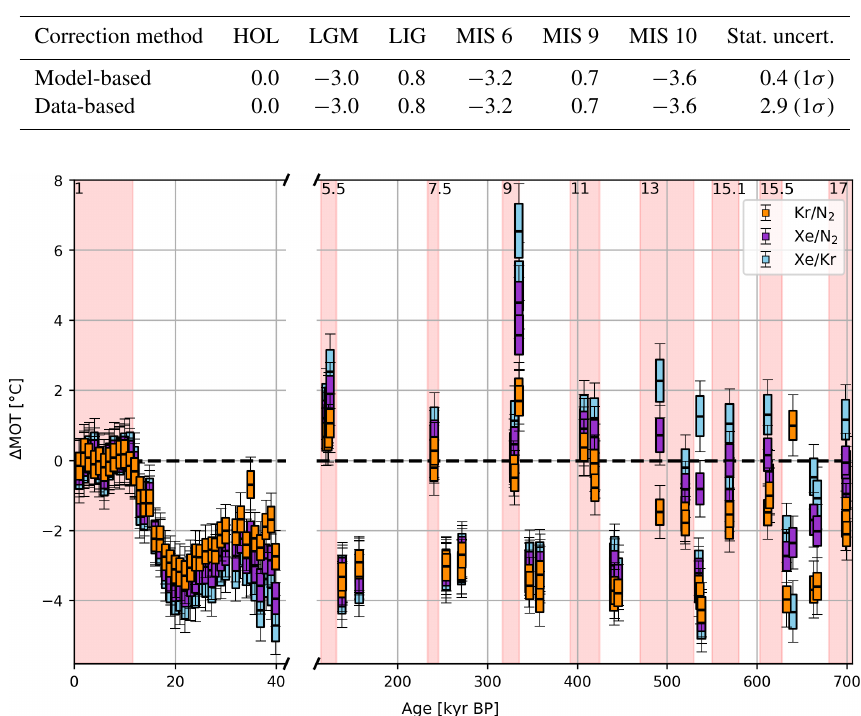
Figure 6. Reconstructed MOT for the EDC samples over the last 700kyr relative to the Holocene value (using the model-based correction). MOTs are derived from δ Kr / N 2 (orange), δ Xe / N 2 (purple), and δ Xe / Kr (blue). The horizontal line in the middle of the filled box provides the corrected value. The boundaries of the filled boxes refer to the systematic uncertainty, while whiskers reflect the stochastic uncertainty introduced by the measurement errors (each 1 σ ). The red shaded intervals and the MIS numbers on top indicate interglacials as identified by Masson-Delmotte et al.